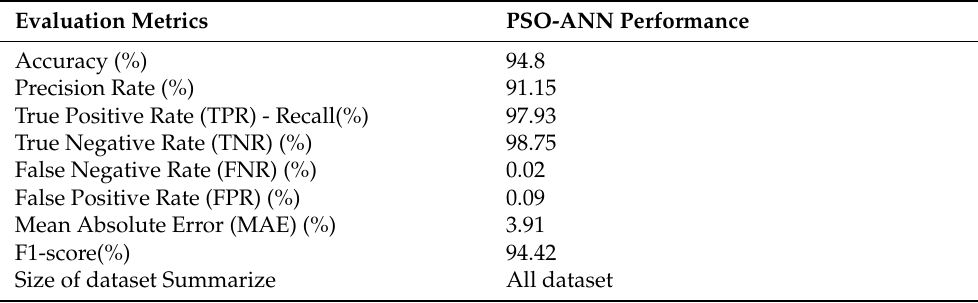
Table 3. Classification performance of the ANN with dataset summarization on MNIST dataset using the proposed